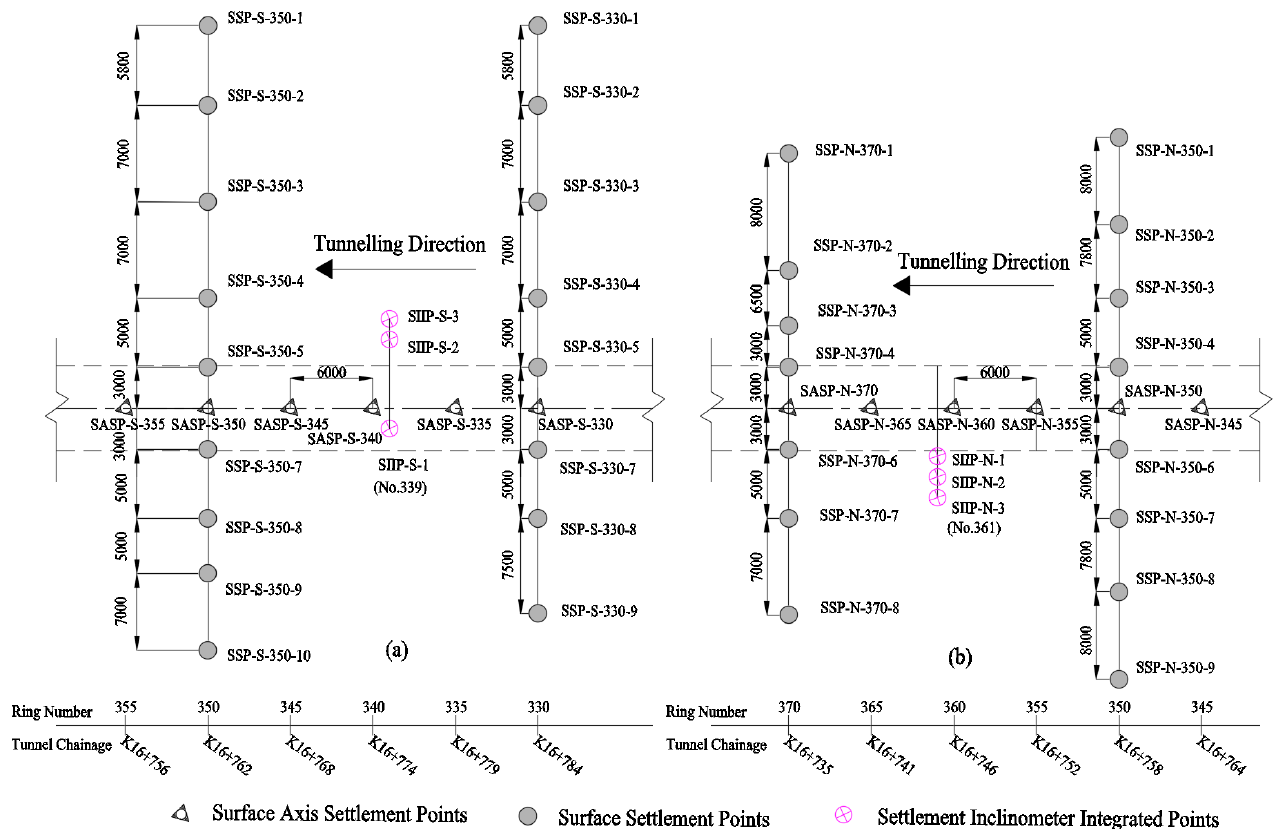
Figure 3. Layout map of surface settlement measuring points: ( a ) south line; ( b ) north line.